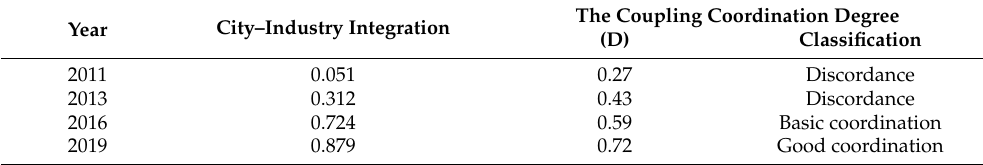
Table 11. Coupling coordination degree and classification results in the Kangqiao industrial park.